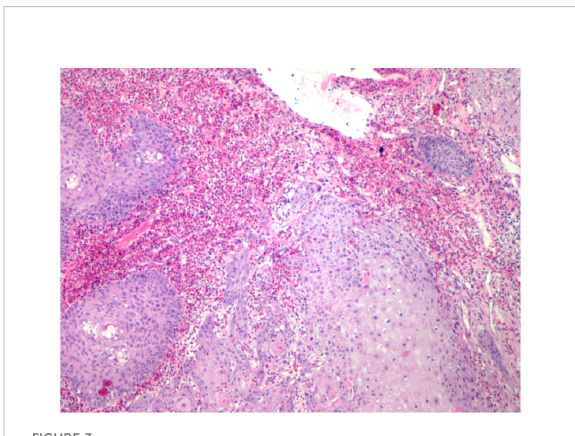
FIGURE 3 Light microscopic fi ndings: atypical hyperplasia of squamous epithelium with suppurative in fl